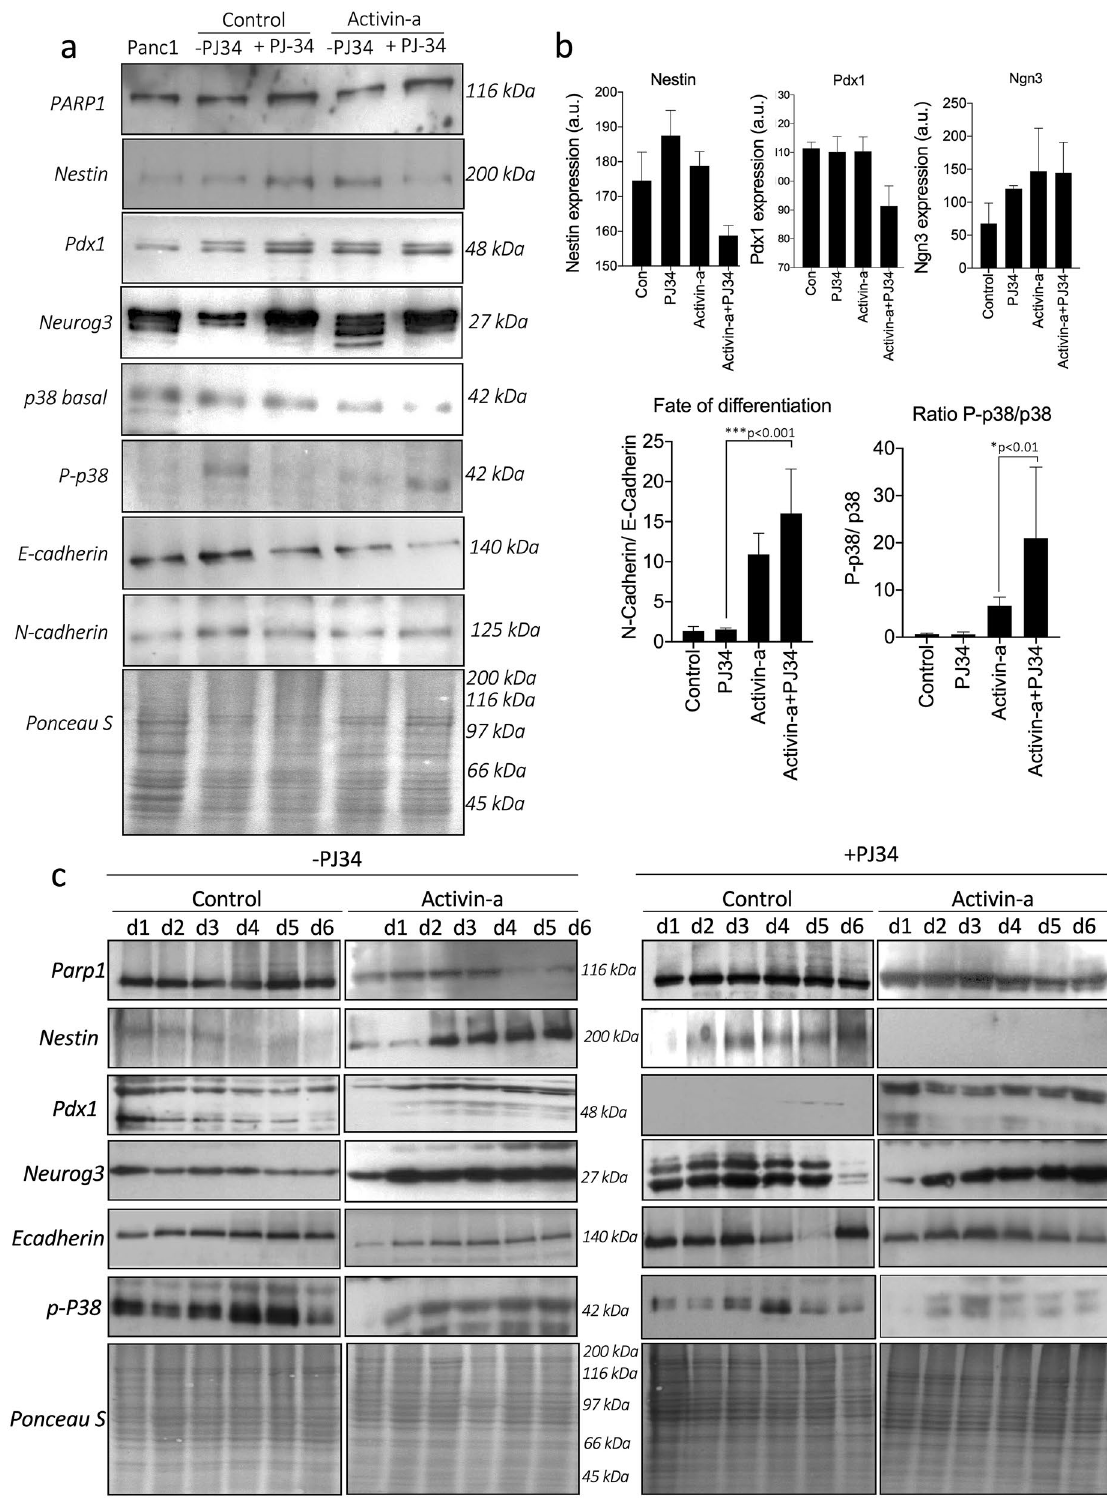
Figure 6. Molecular characterization and quantification of proteomic signals for efficient islet cell differentiation in activin-A treated with and without PJ34 treatment in PANC-1 cells. ( a ) Immunoblotting profile at day 10th of differentiation of PARP-1 expression along with key pancreatic progenitor markers and activin-A induced endocrine pathway proteins that governs pancreatic islet formation from PANC-1 cells. ( b ) Quantification for endocrine reprograming transcription factor, ratio of progenitor (E-cadherin) state vs endocrine β cell (N-Cadherin) state, and MAPK signal (p-p38/p-38) stimulation. ( c ) Short-term (d1-6) protein profiling of differentiation signals initiated within activin-A treated cells with and without PJ34. Data represented as mean ± sem, p-value show significance at 95% confidence interval using two-way anova analysis compared to activin-A cells (n =